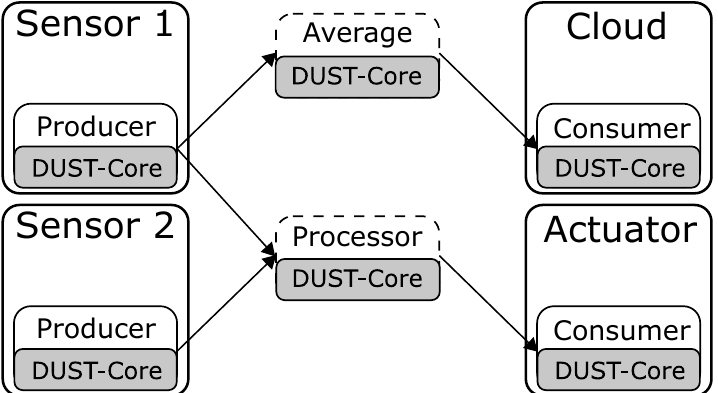
Figure 5. The streaming configuration from sensors to the actuator. The events from sensor 1 are also averaged over time and send to the